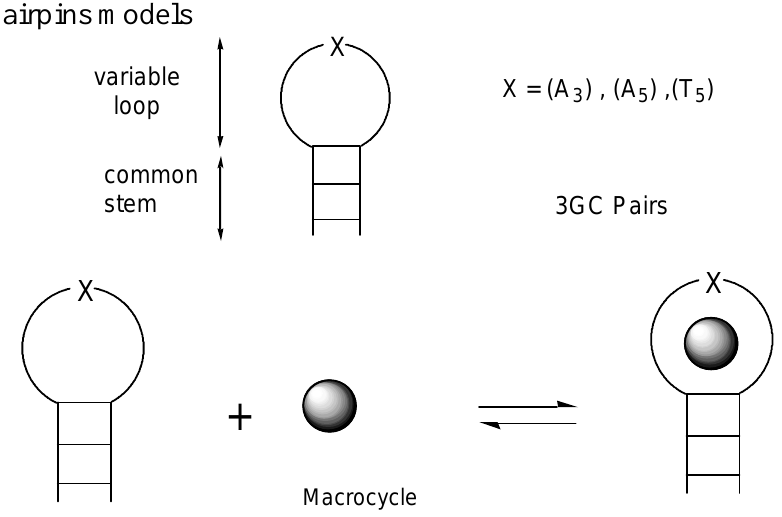
Figure 7. Selective binding of the bisacridine receptor to DNA